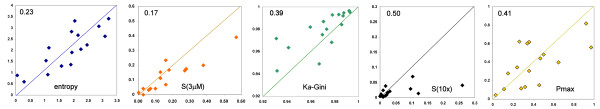
Correlation between specificity values calculated from different datasets. All x-axes: scores from binding data from the Ambit kinase dataset [5]. All y-axes: scores from activity data measured on the same compounds at Millipore. We calculated (in Microsoft Excel, for panels from left to right) the R-squares from linear regression as: 0.93, 0.92, 0.99, 0.54, 0.81 and the correlation coefficients as: 0.81, 0.90, 0.75, 0.57, 0.63. The straight line represents the ideal case of specificity values being insensitive to profiling method. The total squared distance of (normalized) data points to the straight line is given in the top left corner of each panel. For this latter calculation, data were normalized by dividing all values by the highest value in their set. Because the Ka-Gini values are very unevenly distributed, the lowest value 0.93 was first subtracted from all data in this set. Irrespective of statistical method, the selectivity entropy, S(3 μM) and Ka-Gini are the most robust metrics.